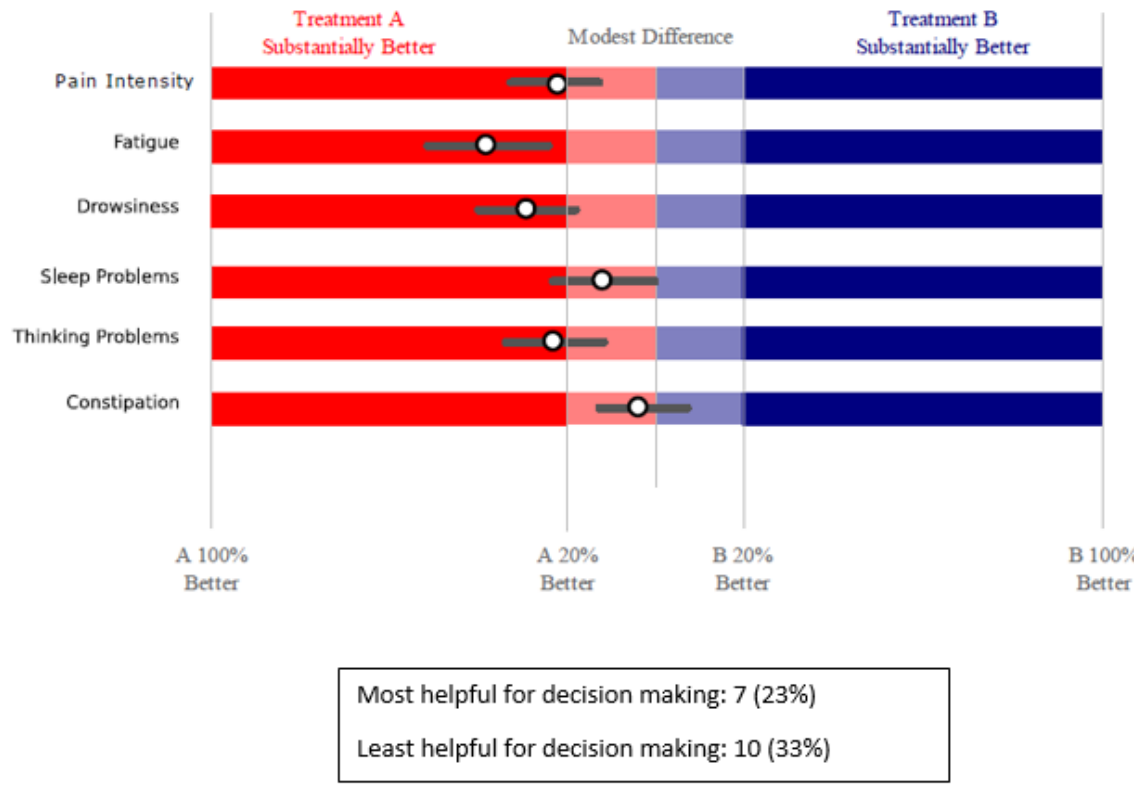
Figure 6. Estimated difference between treatments (bars represent margins of error).